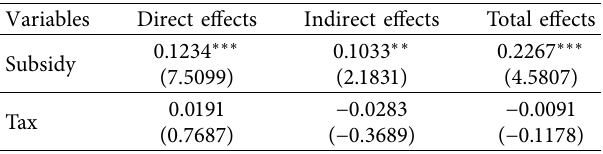
Table 5: Estimated results of the direct, indirect, and total effects based on the